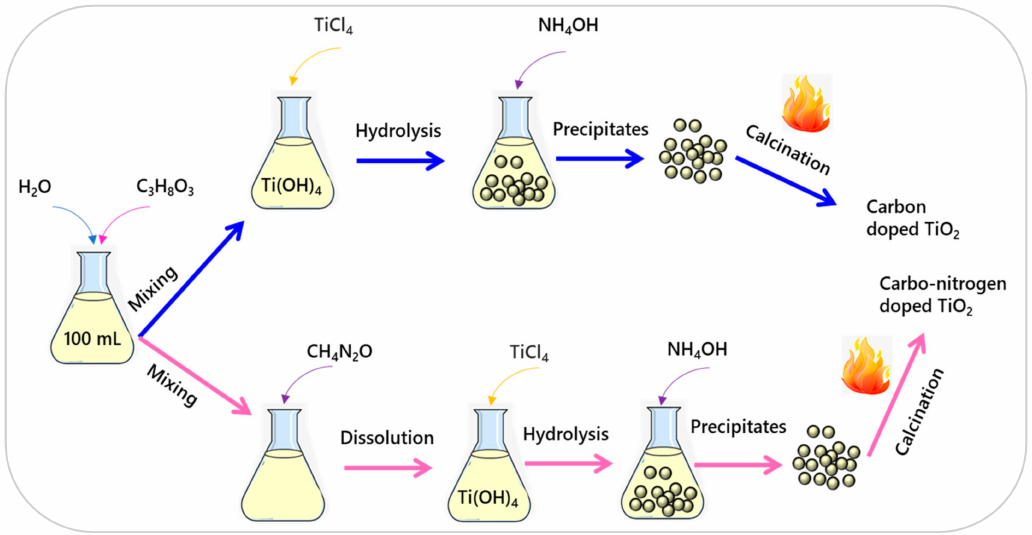
Figure 1. Schematic illustration of the synthesis of CB-TiO 2 and CNB-TiO 2